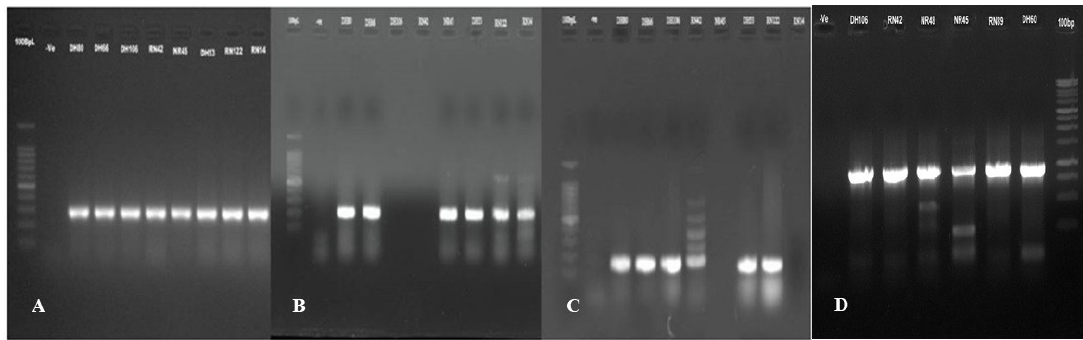
Figure 3. Representative PCR results for the detection of APEC phylogenetic groups among the colibacillosis cases of Bangladeshi poultry samples. Here, ( A ): ( chu A, 279bp), ( B ): ( yja A, 211bp), ( C ): (tspE4.C2, 152bp), ( D ): ( arp A, 400bp), and Lane 1 is molecular ladders (100bp), Lane 2 is negative blank control, and Lanes 3–10 are the strains DH80, DH66, DH106, RN42, NR45, DH53, RN122, and RN14, respectively. DNA bands at the appropriate position were observed in APEC strains DH66, DH80, DH53, and RN122, denoted as phylogroup B2(B2 3 ) ( chu A+, yja A+, arp A‐, tspE4.C2+), APEC strains DH106, RN42 represented as phylogroup D2 ( chu A+, yja A‐, arp A‐, tspE4.C2+), and APEC strains NR45, RN14 denoted as phylogroup B2(B2 2 ) ( chu A+, arp A+, yja A+, tspE4.C2‐).